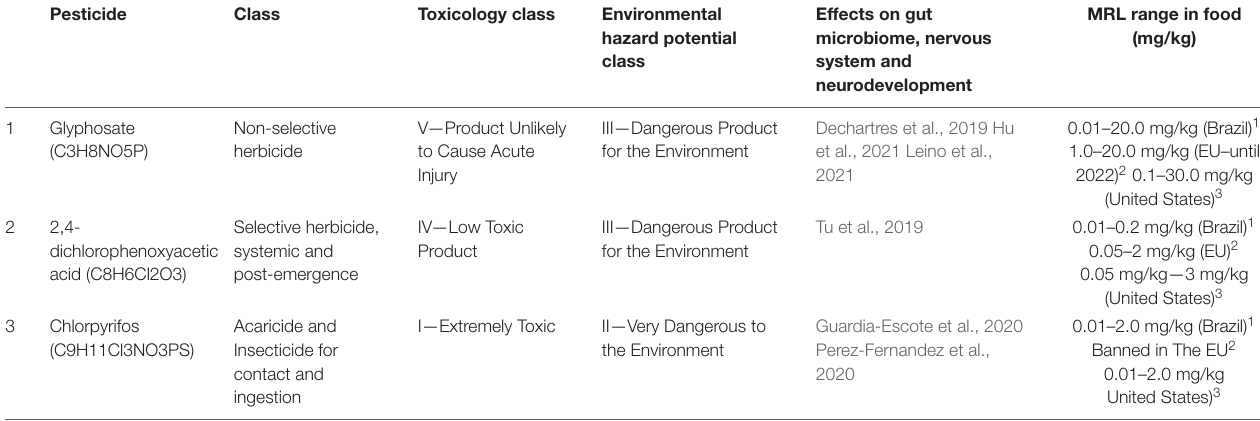
TABLE 1 | Widely used